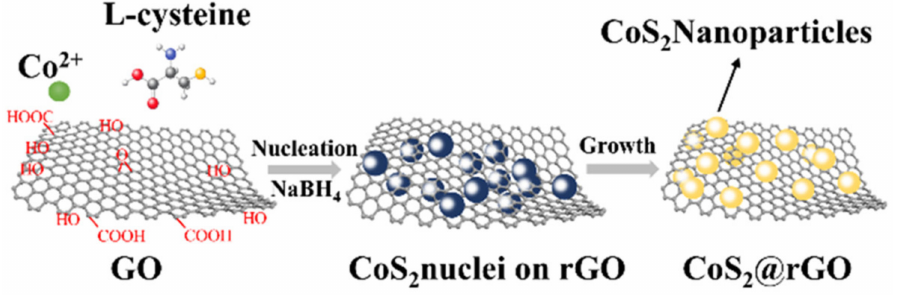
Figure 1. Scheme of the synthesis route of CoS 2